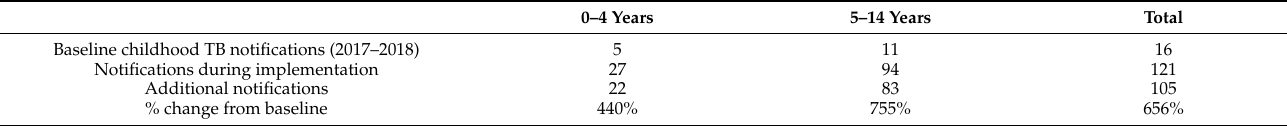
Table 3. Additional childhood TB case notifications compared to baseline by age